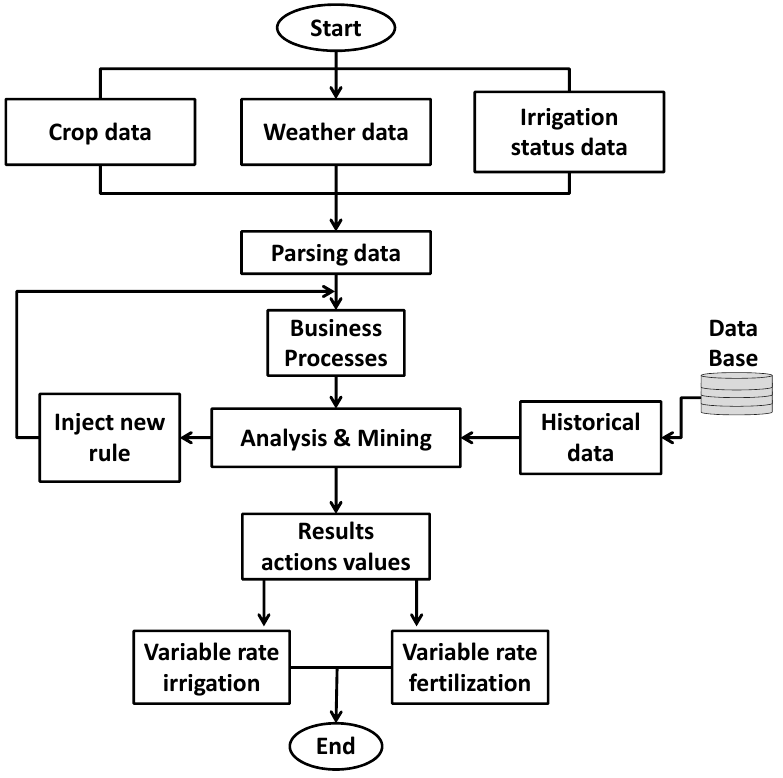
Figure 2. Farming smart decision systems (SDS) flow diagram.